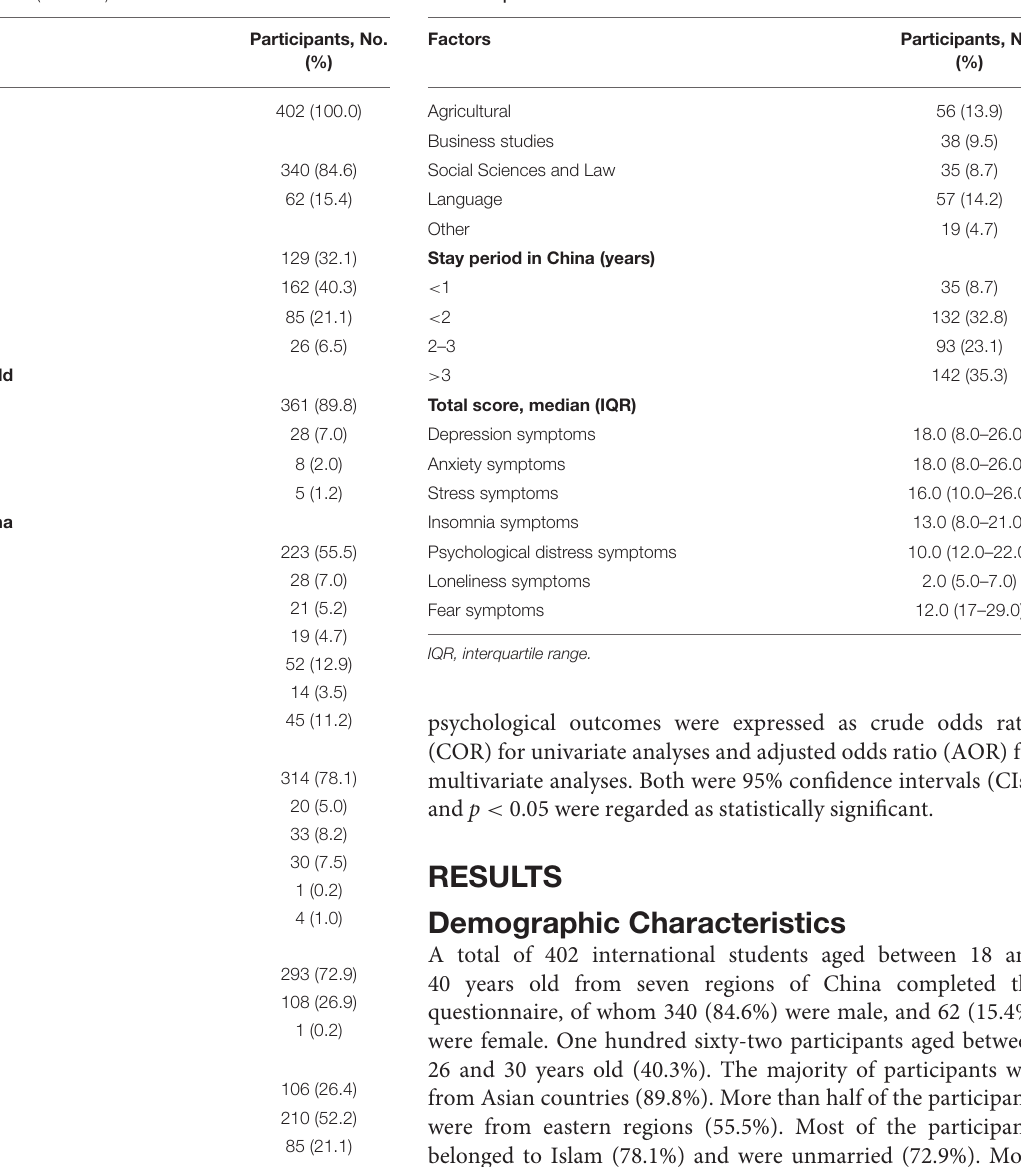
TABLE 1 | Sample characteristics ( N =